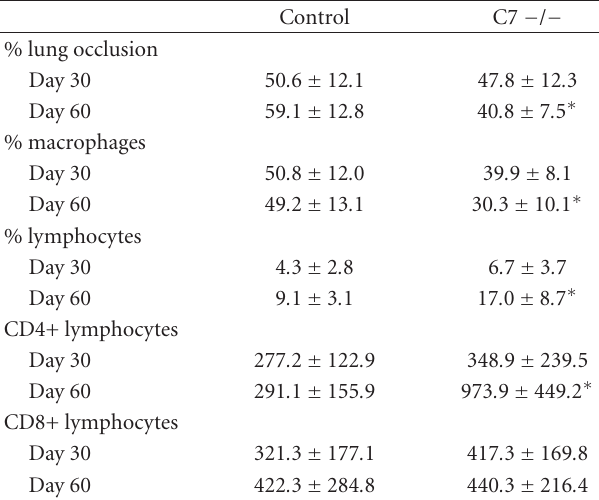
Table 1: Quantitative IHC of wild-type C57BL/6 mice and C7 defi- cient mice infected with